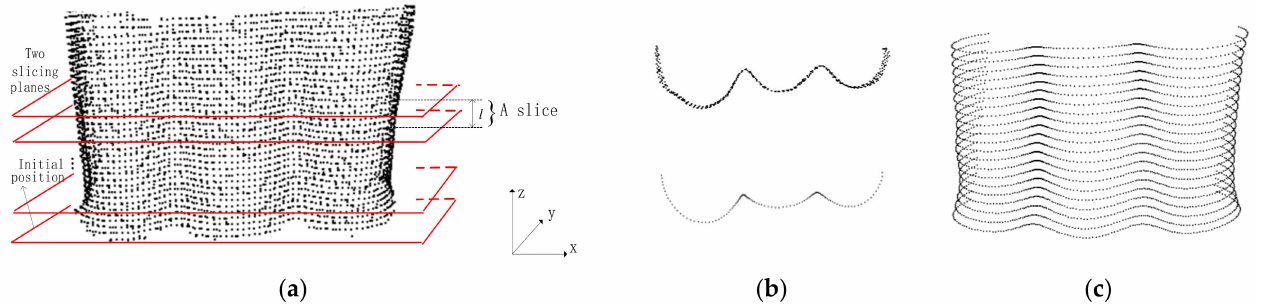
Figure 2. Slicing and resampling of point clouds: ( a ) Slicing of point clouds; ( b ) A slice and a profile; ( c ) Profiles of the point